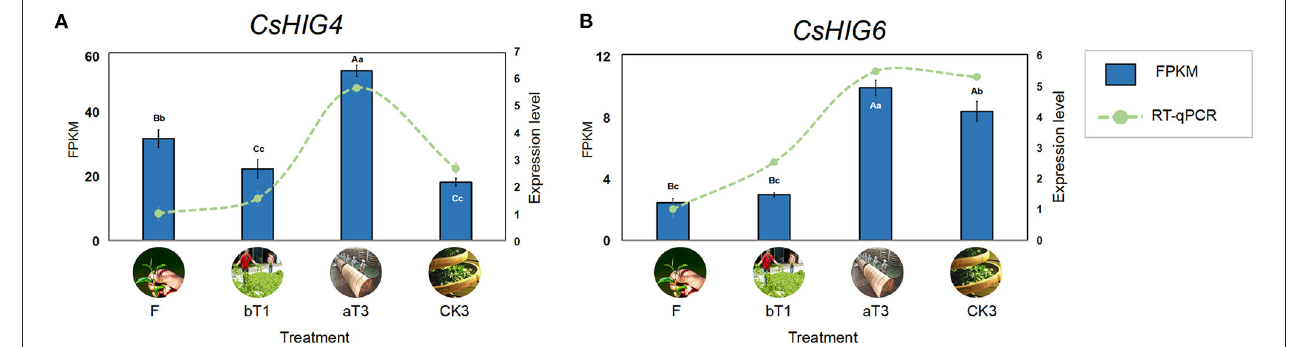
FIGURE 8 | FPKM values and RT-qPCR test verification of key CsHIG gene transcripts during postharvest processing of oolong tea. FPKM values and expression levels of (A) CsHIG4 and (B) CsHIG6 . F, Fresh tea leaves; bT1, tea leaves before first turnover treatment; aT3, tea leaves after third turnover treatment; CK3, control of aT3 without turnover treatment. Different uppercase letters ( P < 0.01) and lowercase letters ( P < 0.05) indicate significant differences among different treatments from Tukey’s test. Error bars indicate the standard error (SE) of the mean.